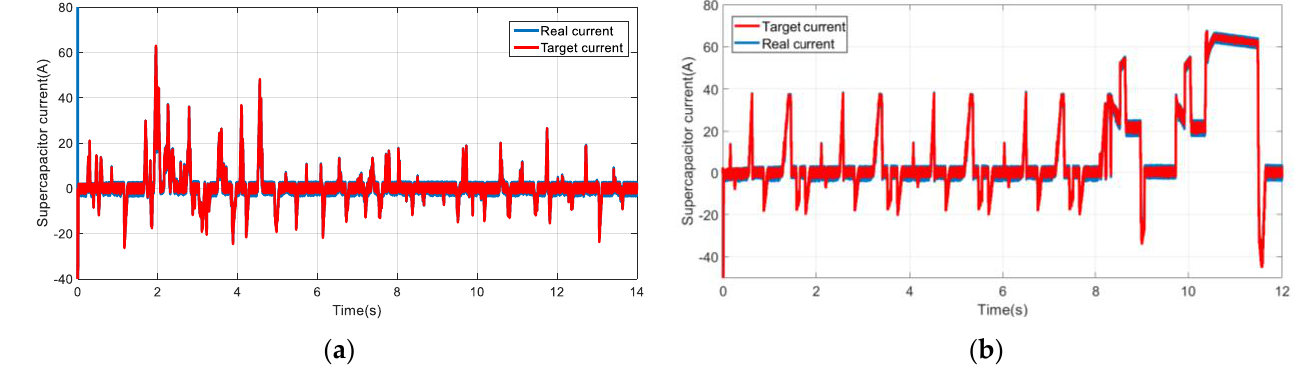
Figure 12. The tracking curves of the supercapacitor current: ( a ) UDDS cycle; ( b ) NEDC cycle.